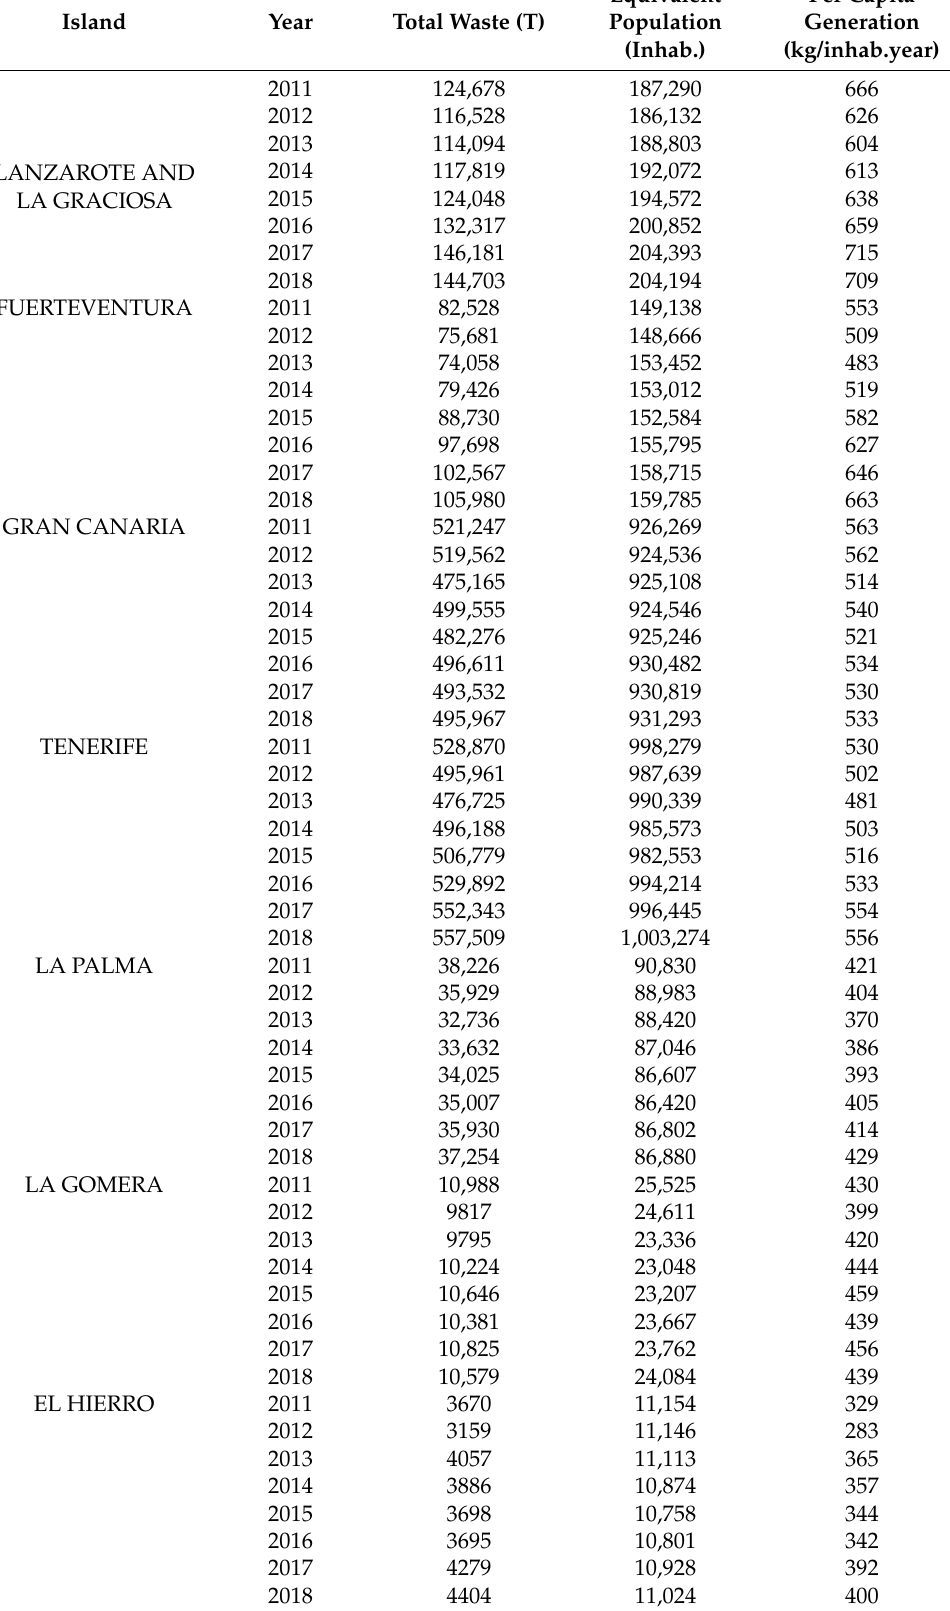
Table 4. Evolution of municipal waste production 2011–2018